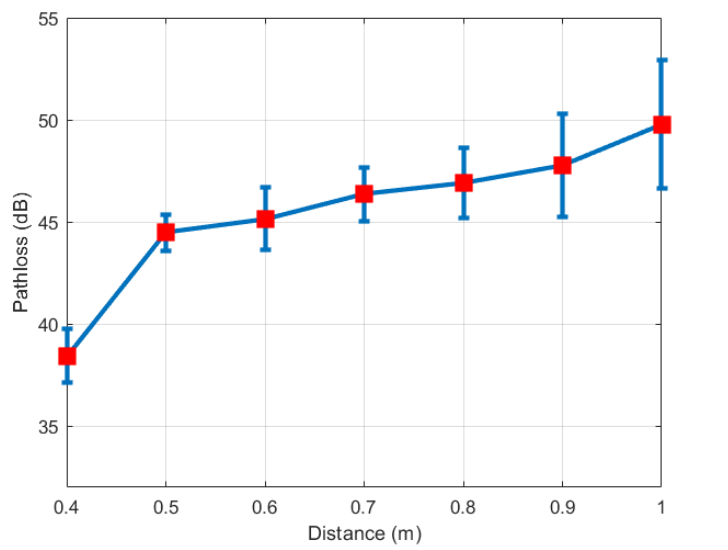
Figure 10. Standard deviation of path loss at P 0 = 0 dBm, 9600 bps.